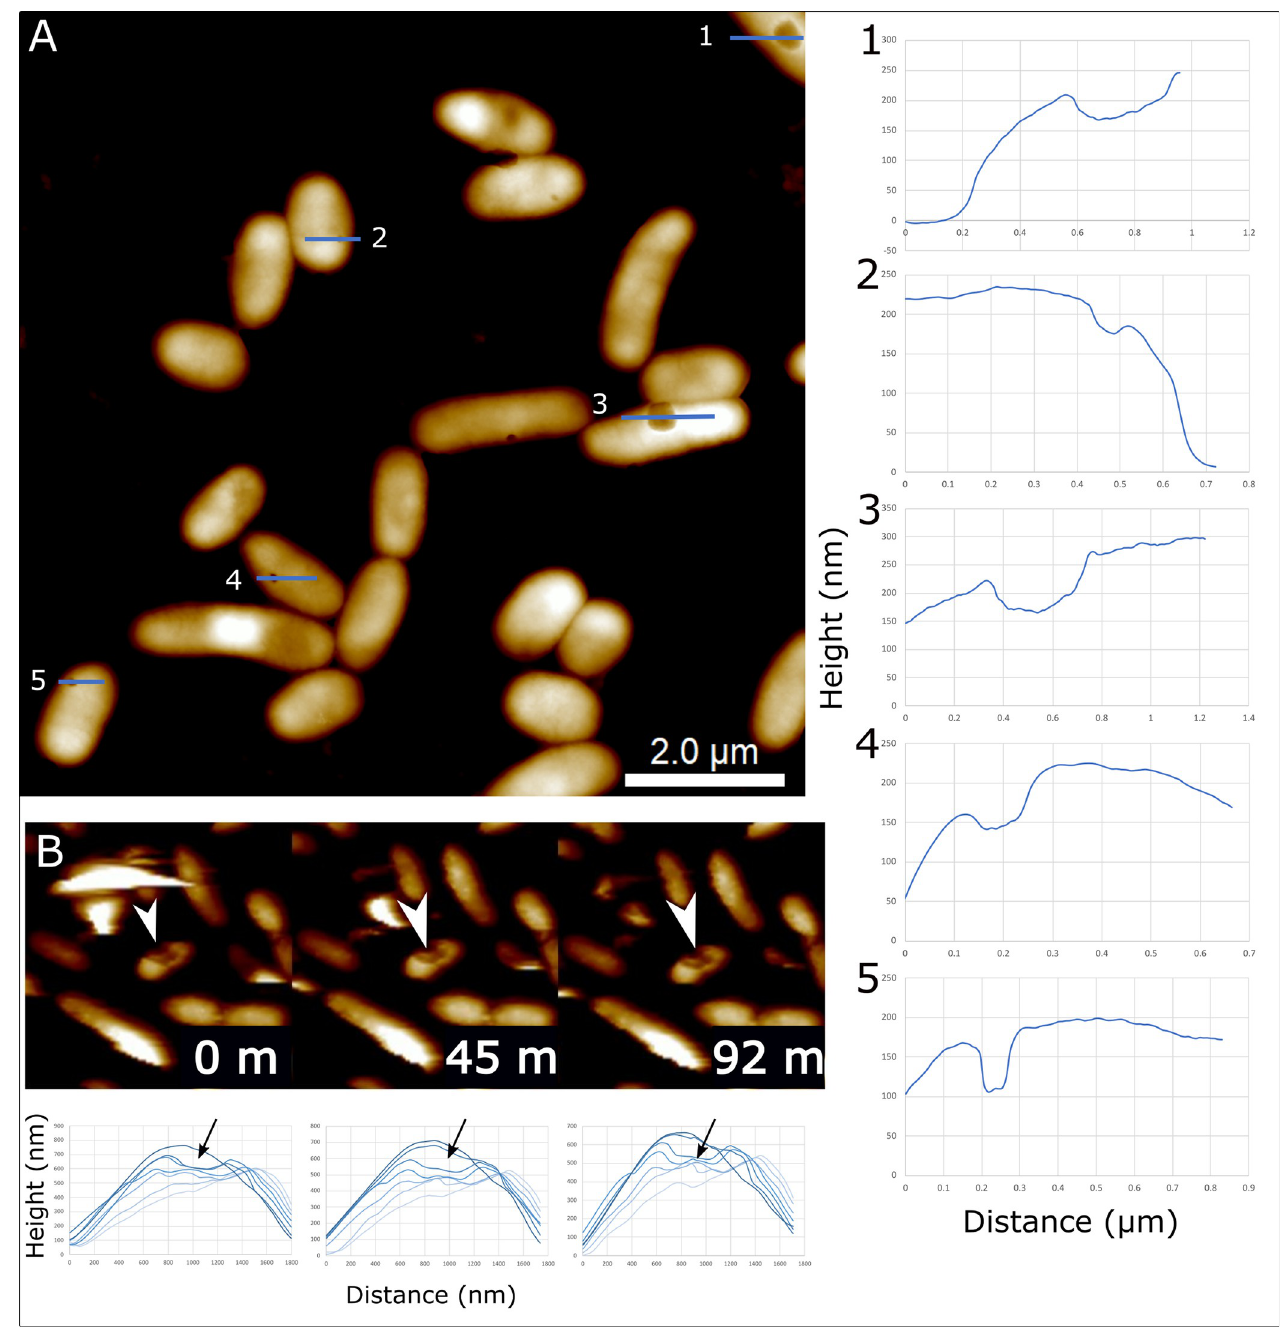
Fig 4. Surface pits form in subset of bacteria and are stable structures in live cells. (A) In TW7 cells, surface pits appear as depressions with variable cross- sectional profiles. Line section graphs (1–5) show the cross-sectional profiles of line segments labelled within the AFM image. (B) A surface pit (white arrow) was observed in fluid imaging of live TW7 cells over a period of 92 minutes, showing consistent pit dimensions and sizes, as shown with respective line traces. Image scan frames are shown at 0-, 45- and 92-minute time points with a scan area of 6.5 μ m x 6.5 μ m. Topographic data from consecutive horizontal line trace profiles across the cell are summarily plotted for each image, showing the height depression of the surface pit (black arrow).